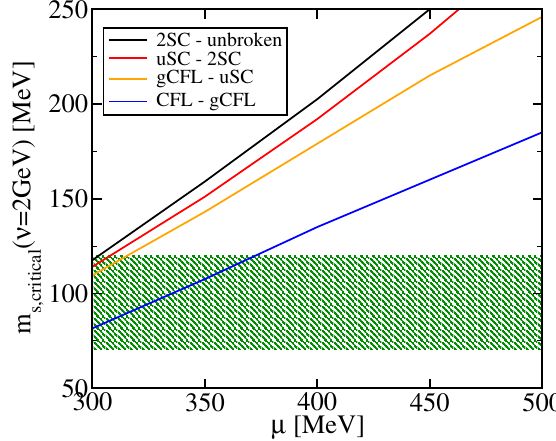
Fig. 5. Color superconducting phases in the m s − µ